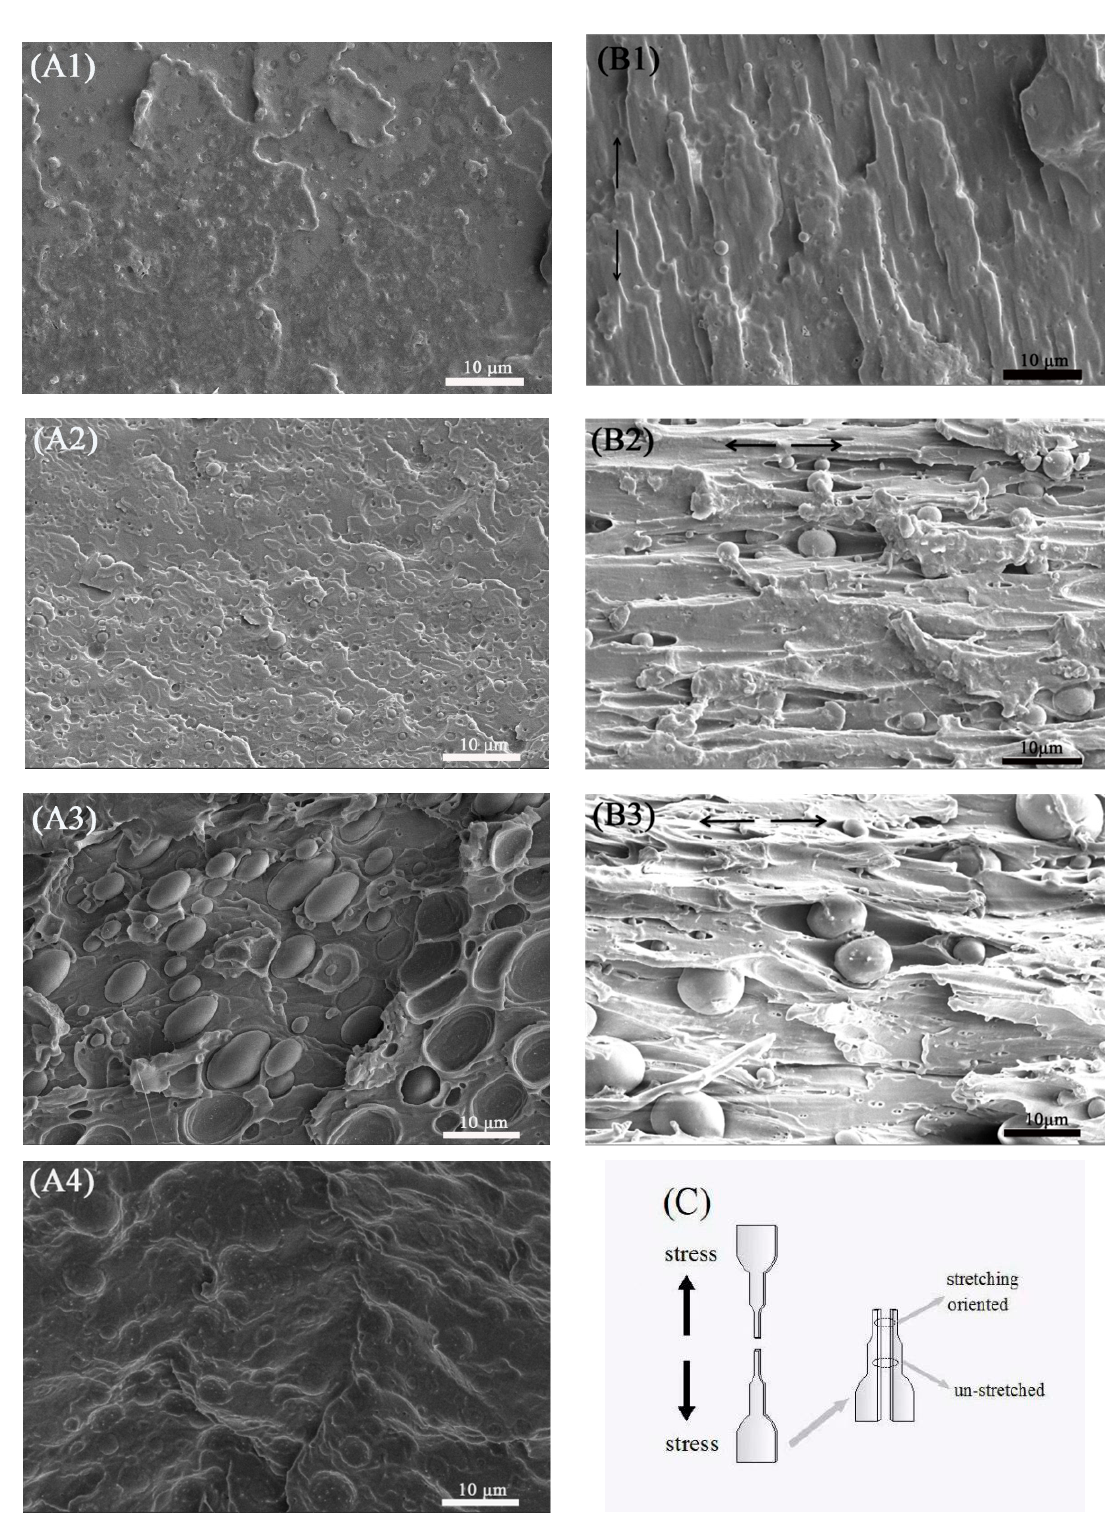
Figure 3. SEM images (×3000) of cryofractured surfaces of PETG/PGA tensile fractured specimens along tensile direction. (A) unstretched part (A1-95/5, A2-85/15, A3-75/25, A4-65/35), (B) stretching-oriented part (B1-95/5, B2-85/15, B3-75/25), and (C) sketching diagram of cryofractured surfaces along tensile direction.